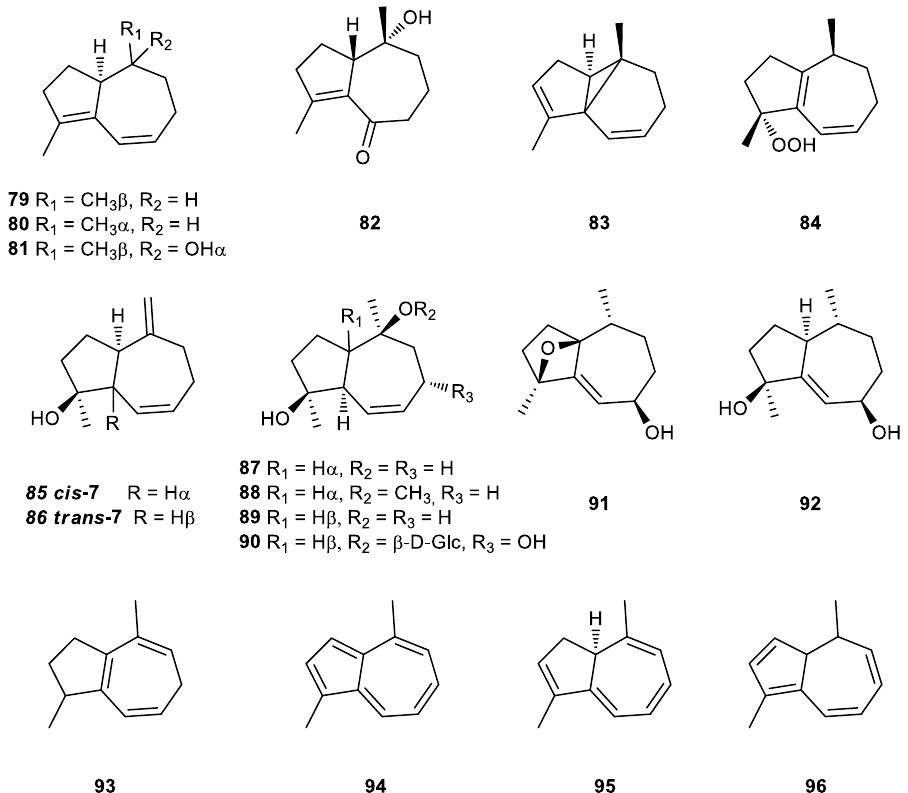
Figure 8. Molecular structure of 11,12,13-tri- nor -guaianes isolated and